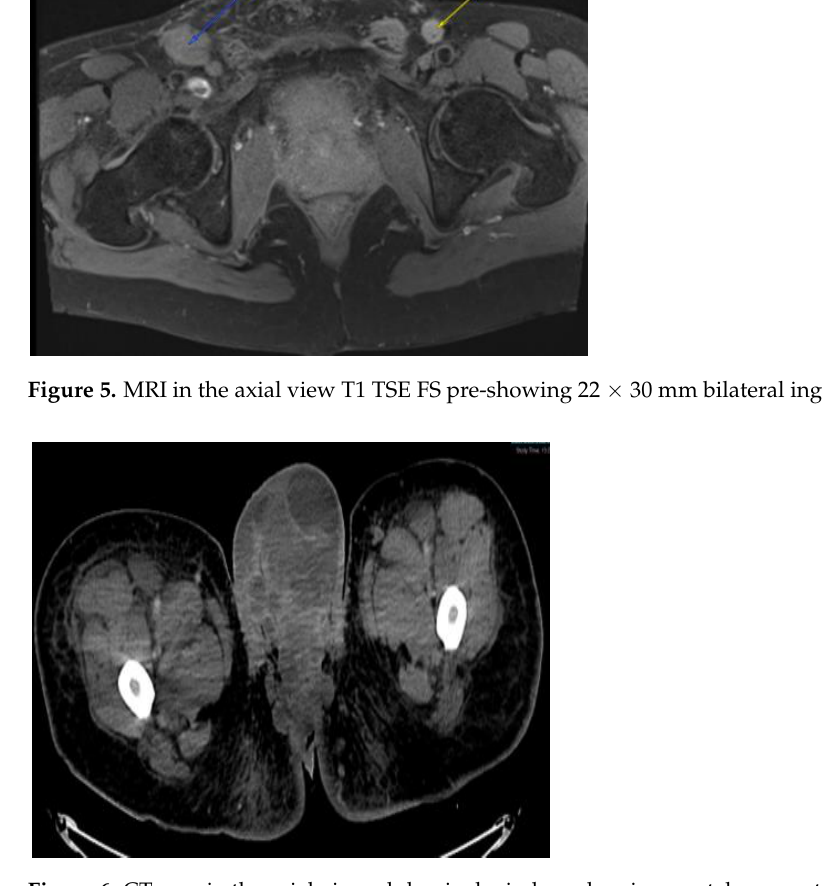
Figure 6. CT scan in the axial view, abdominal window, showing scrotal mass extending through the anus with involvement of ischial tuberosity.